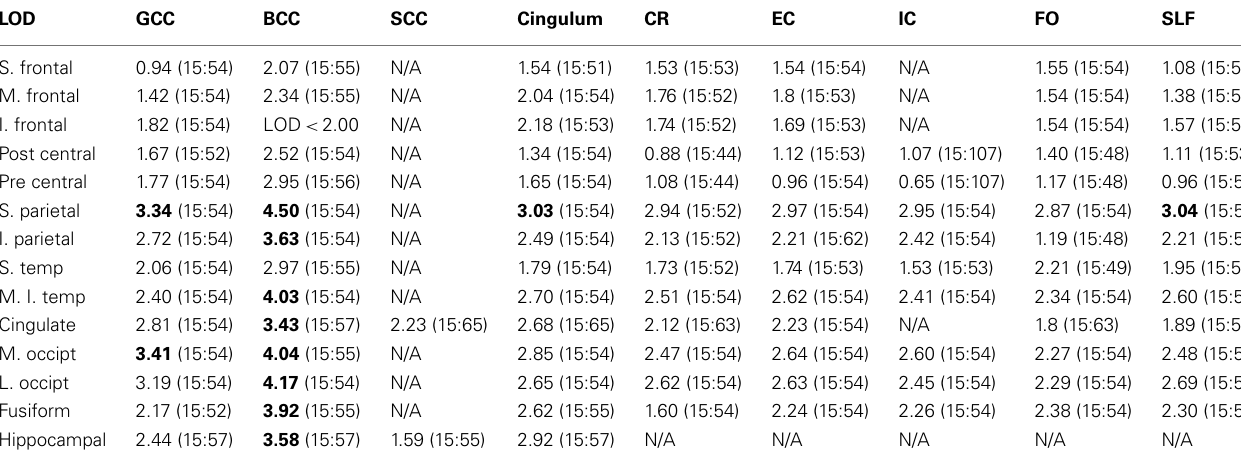
Table 3 | Logarithm of Odds (LOD) values and location of the peak [chromosome: location (cM)] for traits.